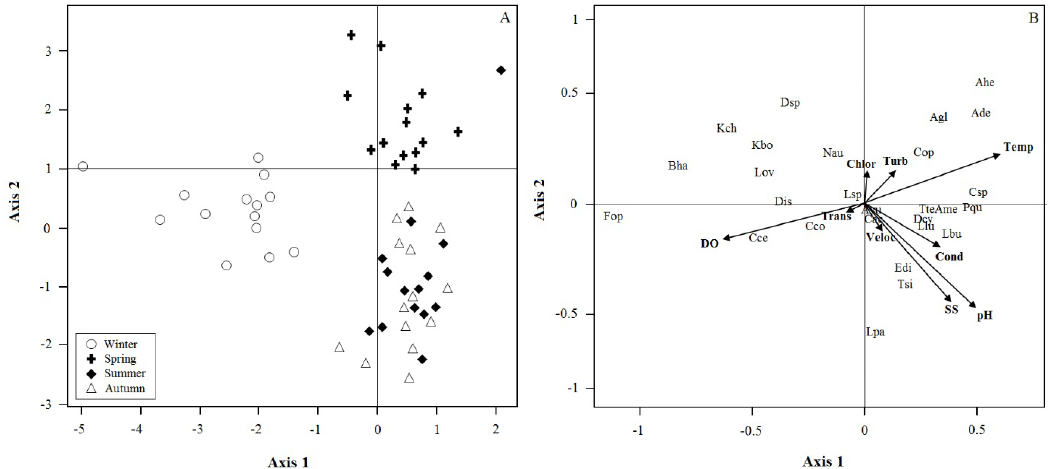
Figure 4. Canonical Correspondence Analysis (CCA). (A) Correlation of the environments and seasons in the Pelotas River sub-basin; (B) Correlation of zooplankton taxa and environmental variables (Abbreviations: Trans, water transpar- ency; DO, dissolved oxygen; SS, Suspended solids; Chlor, chlorophyll- a ; Cond, electrical conductivity; Temp, water temperature; Turb, turbidity; Veloc, water velocity). See Table 3 for abbreviation of zooplankton taxa used in